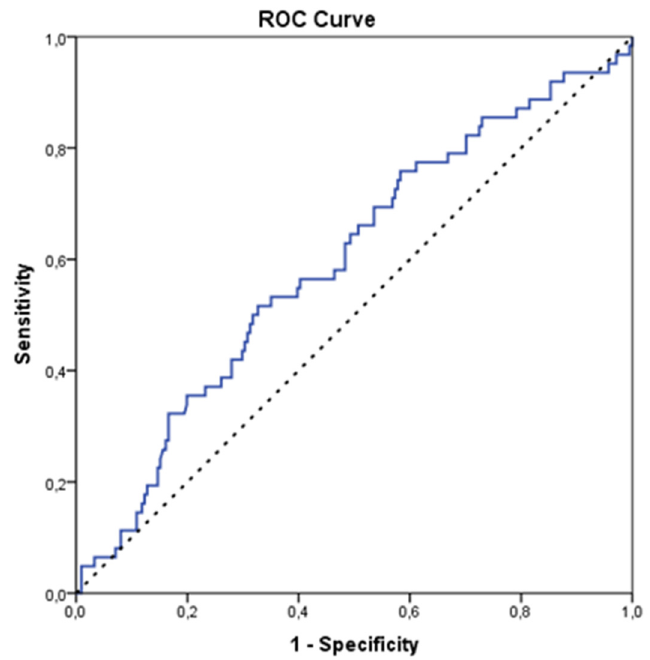
Figure 2. Predictive ability of PLR for having PYMS > 1 according to ROC analysis.